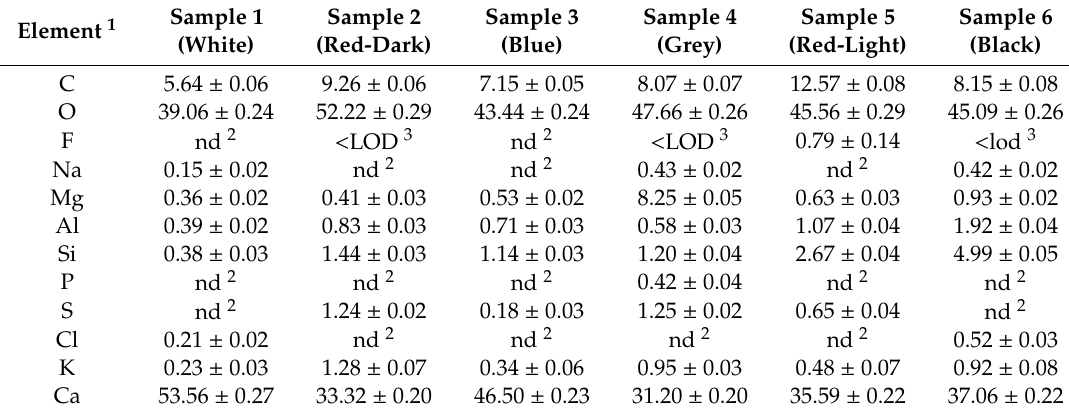
Table 3. The major and minor elements determined by FE‐SEM‐EDS in the studied mosaics fragments, expressed in wt.% ± S.D.%, normalized to 100 wt.%.